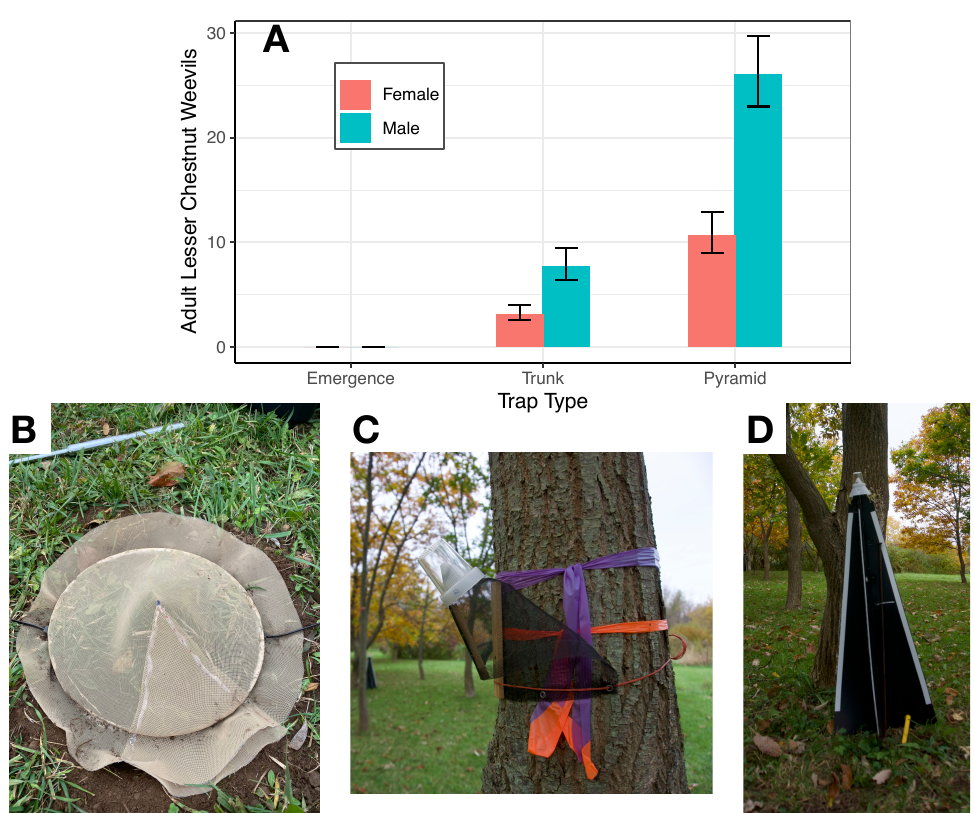
Figure 2. Monitoring the lesser chestnut weevil ( C. sayi ). ( A ) C. sayi male and female trap catch across three trap types. No weevils were ever caught in emergence traps. Bars and error bars denote average monthly catch and 95% confidence intervals, respectively. ( B ) Emergence trap/microcosm cover. This picture shows a conical cover for a buried microcosm. The emergence trap is functionally similar but 1 m in diameter. These traps were used to collect adult weevils emerging from the soil. ( C ) Trunk trap for collecting adult C. sayi moving upward along tree trunks. ( D ) Pyramid (Tedders) trap for collecting adult C. sayi emerging from the ground and moving toward dark upright